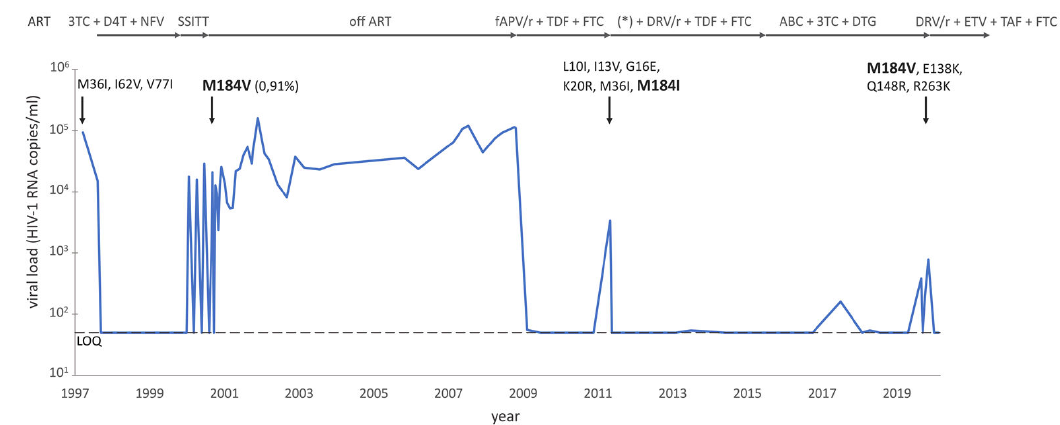
Figure 1. Virological evolution and emergence of resistance-associated mutations (arrows pointing downwards) of our patient since initiation of antiretroviral